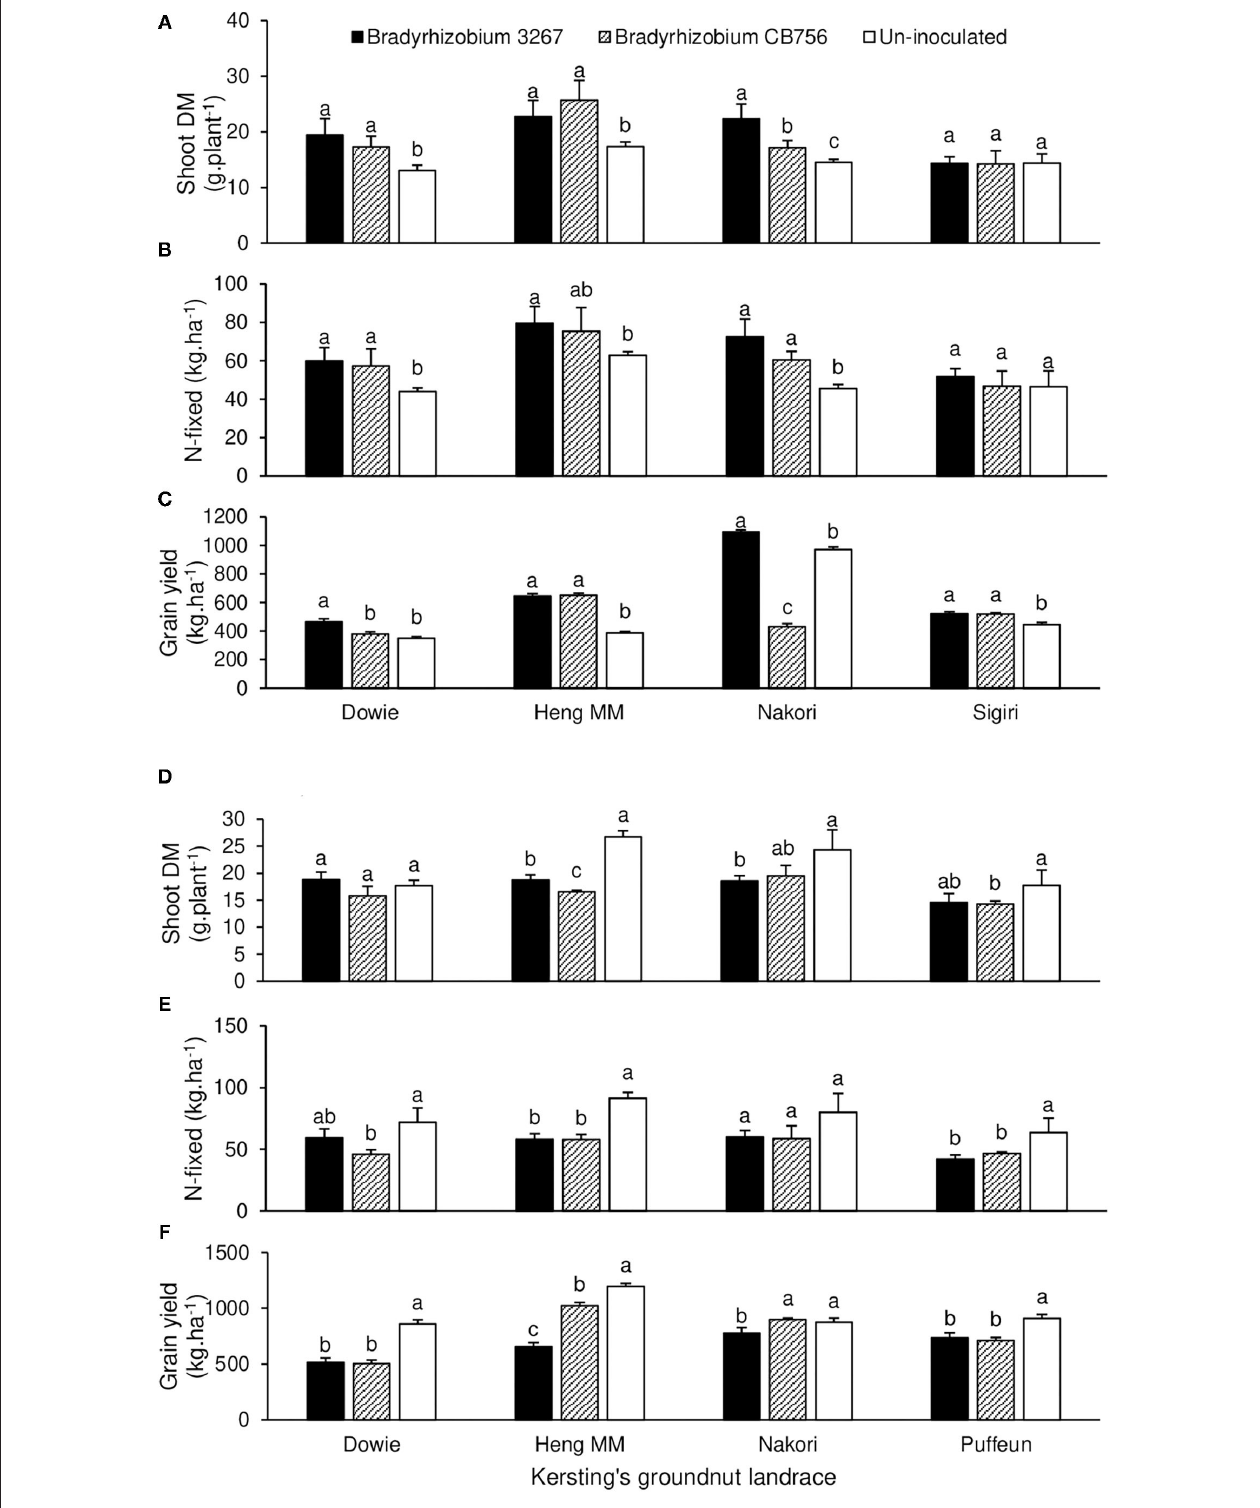
FIGURE 2 | The interactive effect of landrace × inoculation on (A) shoot dry matter at Savelugu, (B) N-fixed as Savelugu, (C) grain yield at Savelugu as well as the interactive effect of landrace × inoculation on (D) shoot dry matter at Nyankpala, (E) N-fixed at Nyankpala, and (F) grain yield at Nyankpala in 2013. For each landrace, bars with dissimilar letters are significantly different ( p ≤